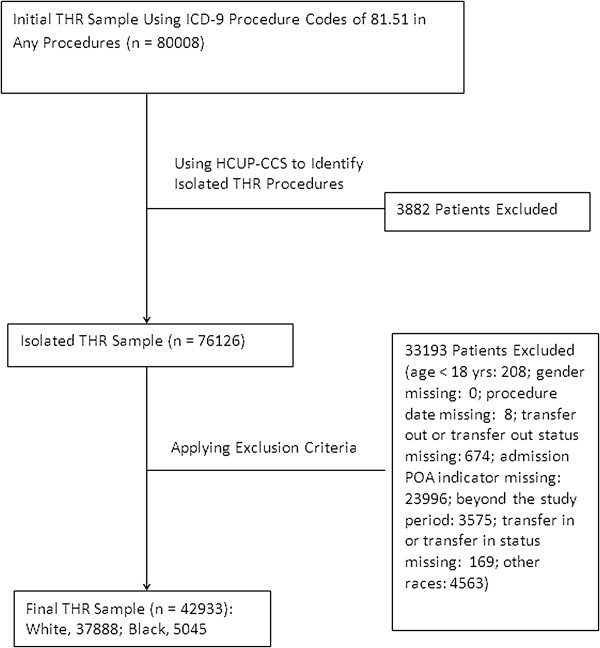
Flow chart for THR sampling.